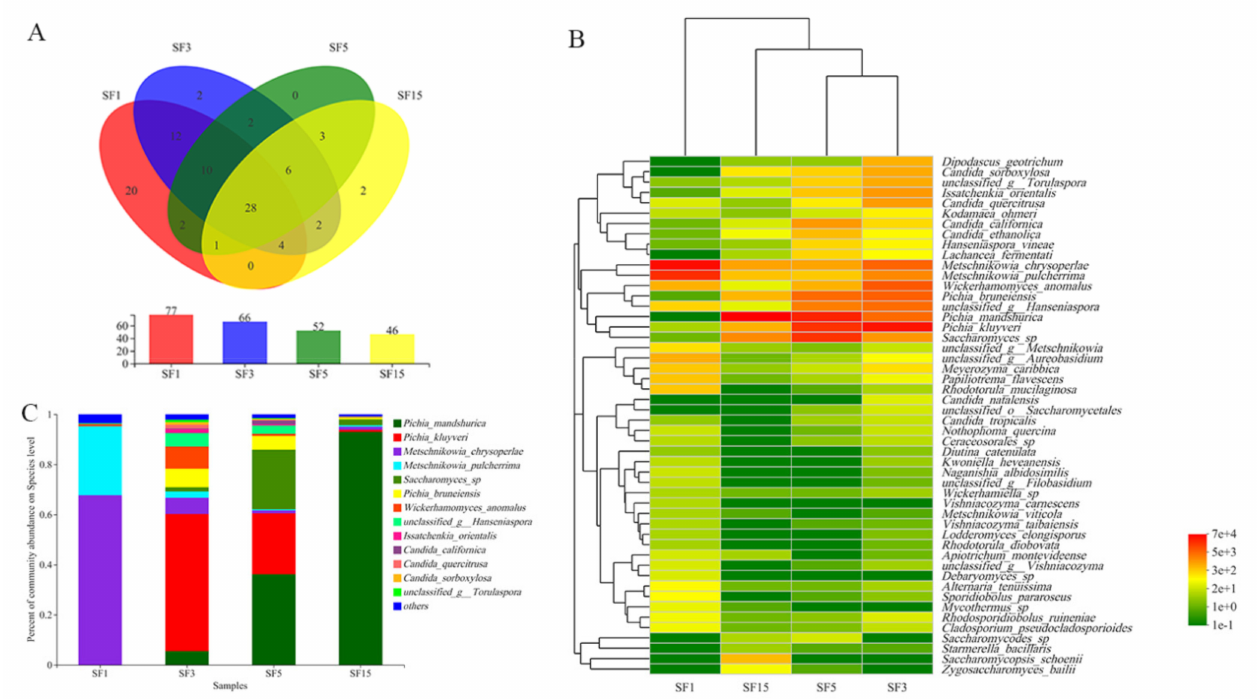
Figure 1. Biodiversity and dynamic changes of non -Saccharomyces yeasts of KFP. ( A ) Yeast community distribution from different spontaneous fermentation stages by Venn diagram. ( B ) Community heatmap analysis on species level. ( C ) Relative abundance of yeast community and their dynamic changes for different spontaneous fermentation